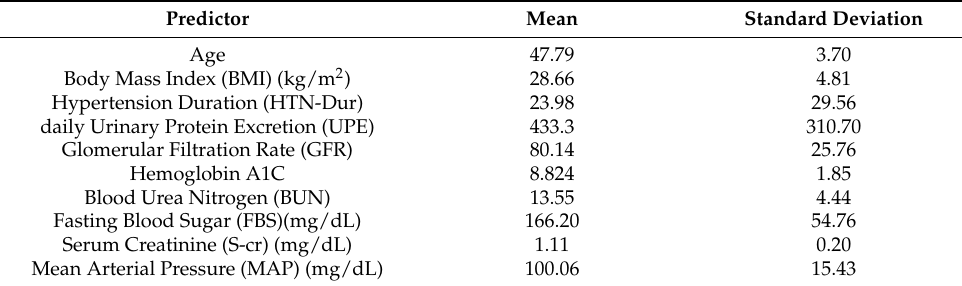
Table 1. Demographic and clinical characteristics of 168 diabetic patients.